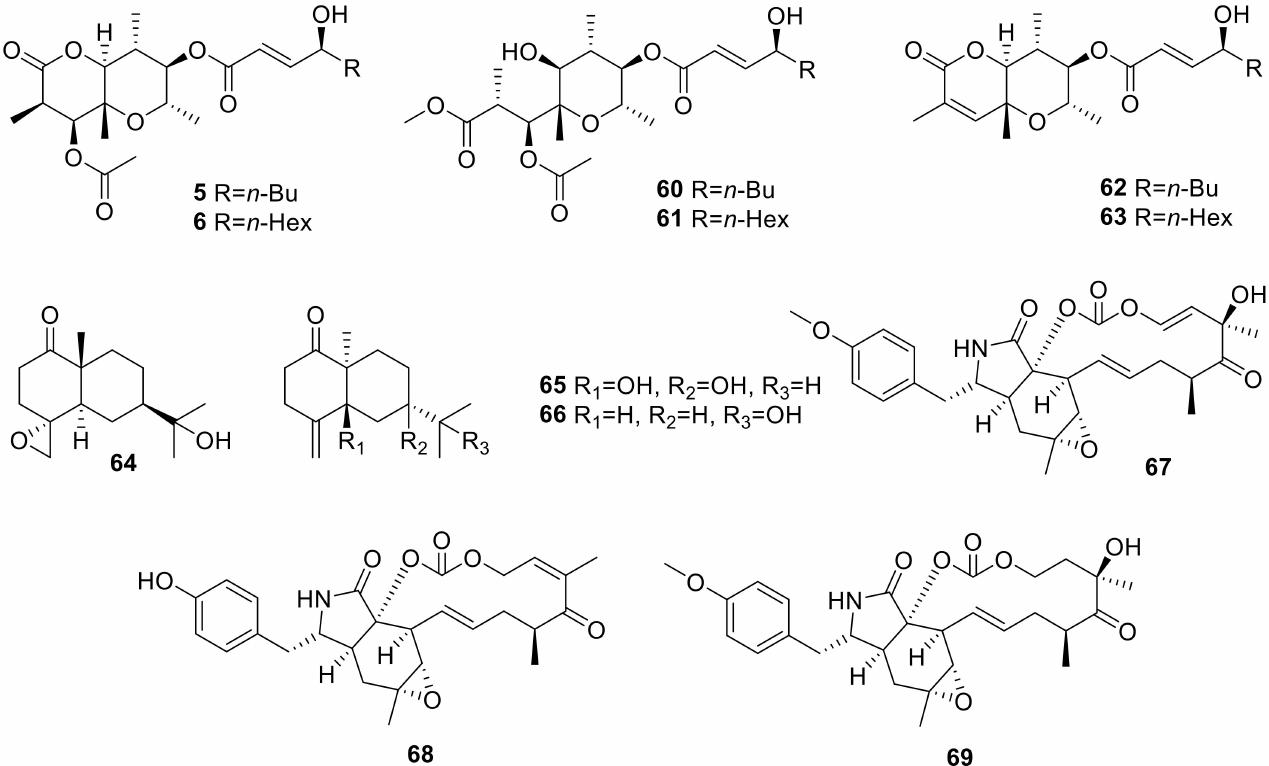
Figure 18. Structures of compounds 5 , 6 , 60-69 .